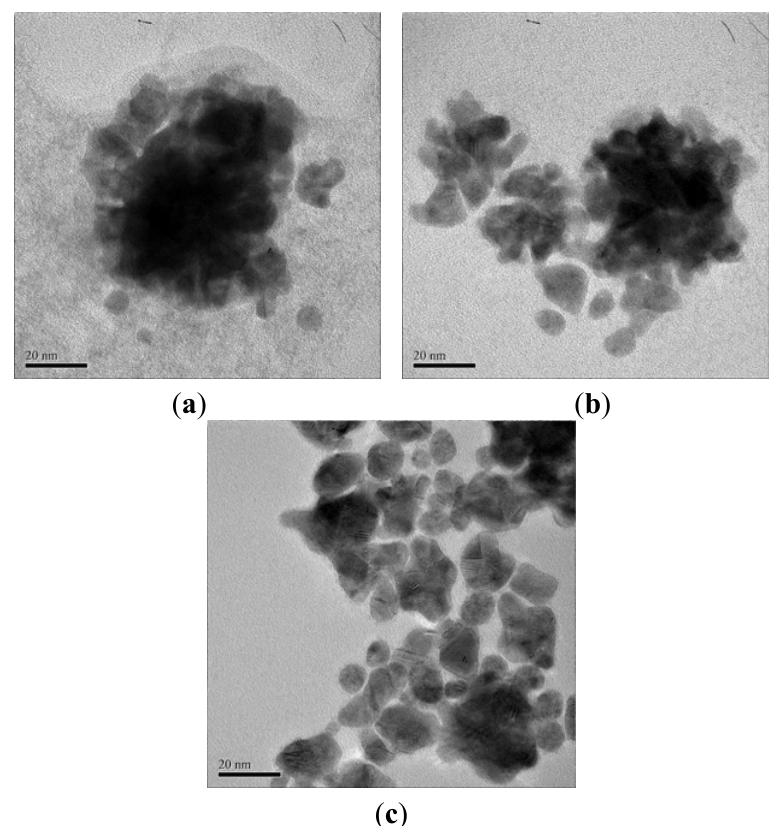
Figure 5. TEM images of gold nanoparticles in DNA matrix with different